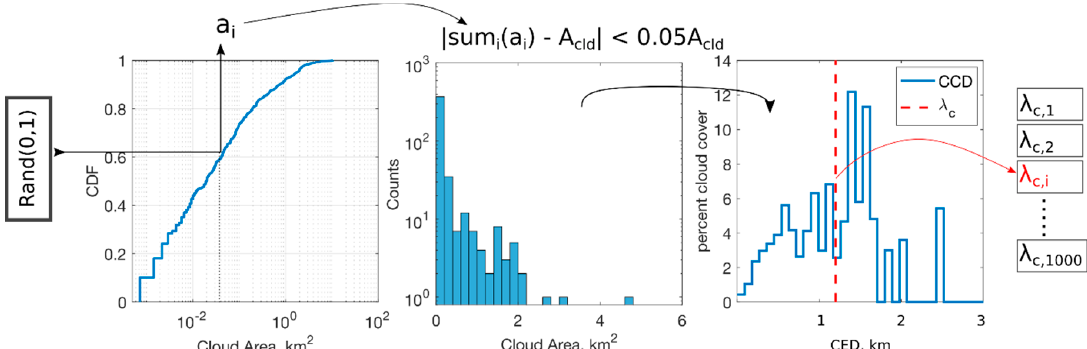
Figure A4. Cartoon of inverse-sampling of TSI or TSI-like cloud size to derive the ensemble mean and confidence interval of characteristic cloud size ( λ c ). Uniformly distributed random numbers on (0,1) are used to draw cloud areas ( a i ) from the TSI or TSI-like CDF. The stopping criteria is set such that the sum of the a i is equal to the total cloud area ( A cld ) from the Landsat subarea within a 5% tolerance. The normalized cloud cover density (CCD) is then computed and characteristic size, λ c , is calculated. This inverse sampling routine is repeated until 1000 values of λ c are obtained. The mean and 95% confidence interval (CI) of λ c are reported and compared to the Landsat subarea (Figure A5b,c).